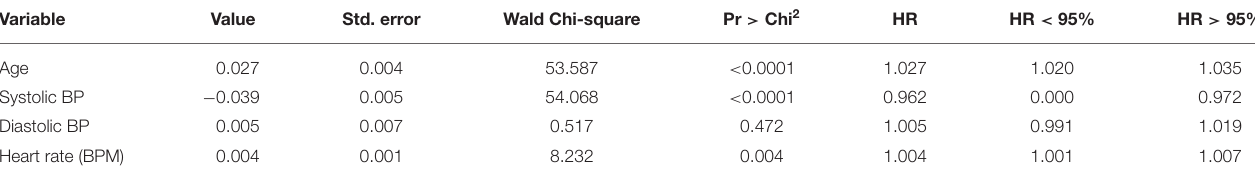
TABLE 9 | Regression coefficients.